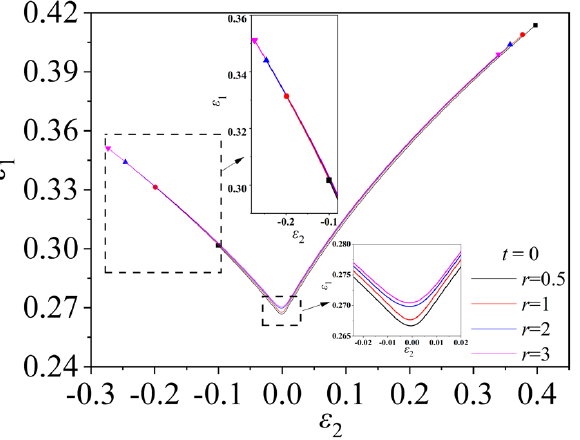
Figure 16. FLD for different r values based on MMFC instability criterion and Hill48 yield criterion at t = 0.